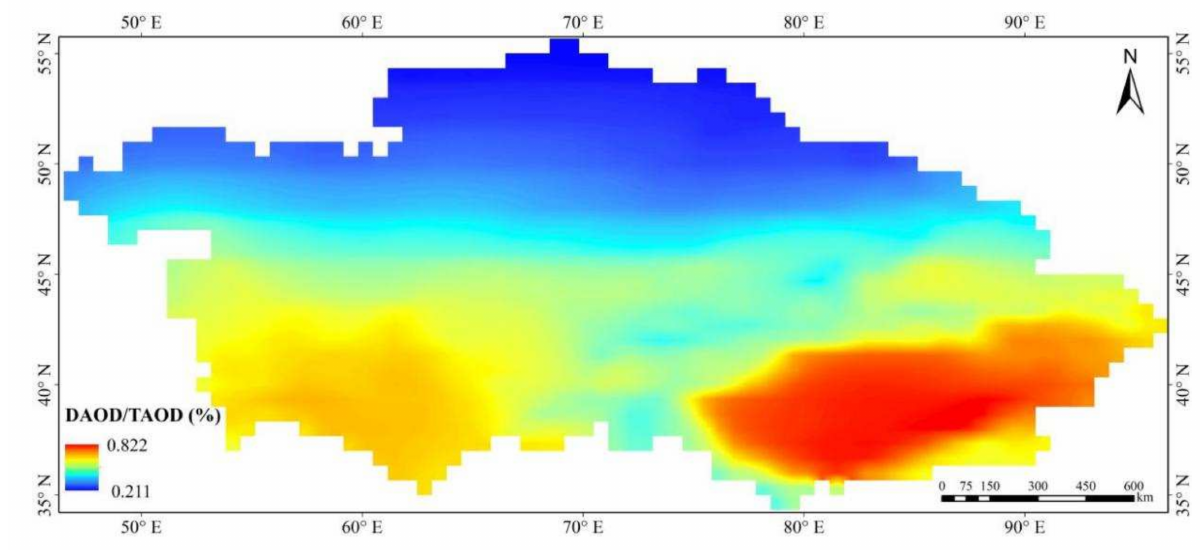
Figure 5. Dust aerosols as a percentage of total aerosols.